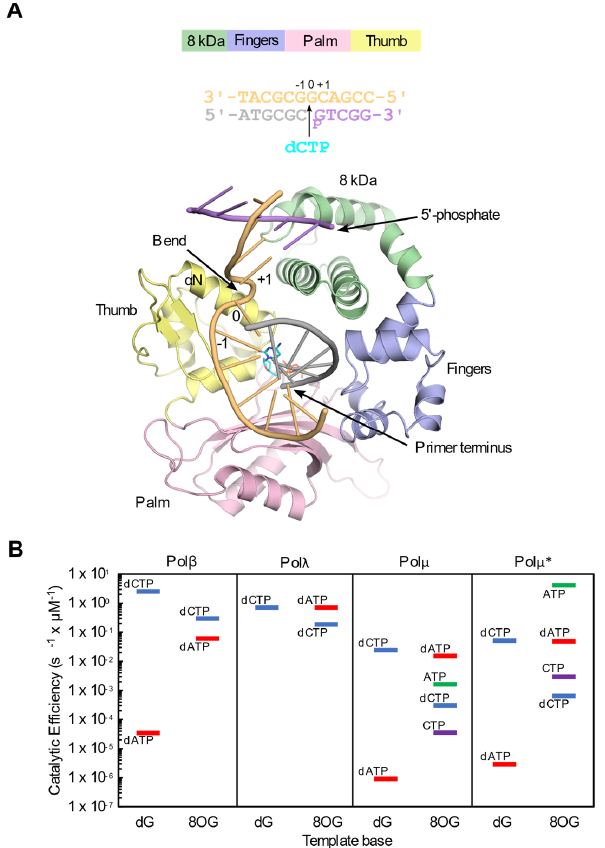
Figure 1. Comparison of catalytic efficiencies for nucleotide insertion by the Family X polymerases opposite undamaged template dG versus 8OG. ( A ). Diagram of domain architecture (top), gapped DNA substrates (middle) and global structure (bottom) of the Family X polymerase catalytic do- main. Crystal structure of Polβ ternary complex with unmodified 1nt-gapped DNA substrate (PDB ID code 4KLD [32] and incoming nucleotide (cyan). The individual subdomains are colored as spec- ified at top. Oligonucleotides are colored as follows—template in khaki, upstream primer in gray, and downstream primer in lavender. Locations of the 5′-phosphate, primer terminus (opposite the −1 position), template bend, and nascent base pair binding site (0 position) are indicated. ( B ). Kinetic parameters for deoxyribonucleotide (dCTP in blue, dATP in red) or ribonucleotide (CTP in purple, ATP in green) incorporation by Pols β [33], λ [34], and µ [35] in the context of a 1nt-gapped DNA substrate. Catalytic efficiencies for incorporation by Polµ were also normalized for experimentally determined cellular concentrations of nucleotide triphosphates [36] (calculated catalytic efficiency multiplied by nucleotide concentration, right panel, indicated by asterisk). Polymerases (Pols) β and λ participate in BER. Polβ is the main polymerase in the short-patch BER pathway—which removes and replaces a single nucleotide—with Polλ playing a backup role in this process [37,38]. Long-patch BER involves the repair of 2–10 nucleotide stretches in DNA [39]. In BER initiated by MUTYH glycosylase, either Polβ or Polλ could insert dC or dA into the single-nucleotide gap, as neither has a marked prefer- ence during insertion opposite 8OG (Figure 1B). Insertion of dA would result in a futile repair cycle. However, it has been reported that the MUTYH-initiated repair preferentially proceeds through the long-patch BER pathway [40–43], and that Polλ, which discrimi- nates against the 8OG:A mispair at the extension step [34], efficiently extends the dC:8OG pair [44], performing error-free bypass. Polλ, like Polµ, participates in the repair of dou- ble-strand breaks (DSBs) by non-homologous end joining (NHEJ) [45]. Along with TdT,